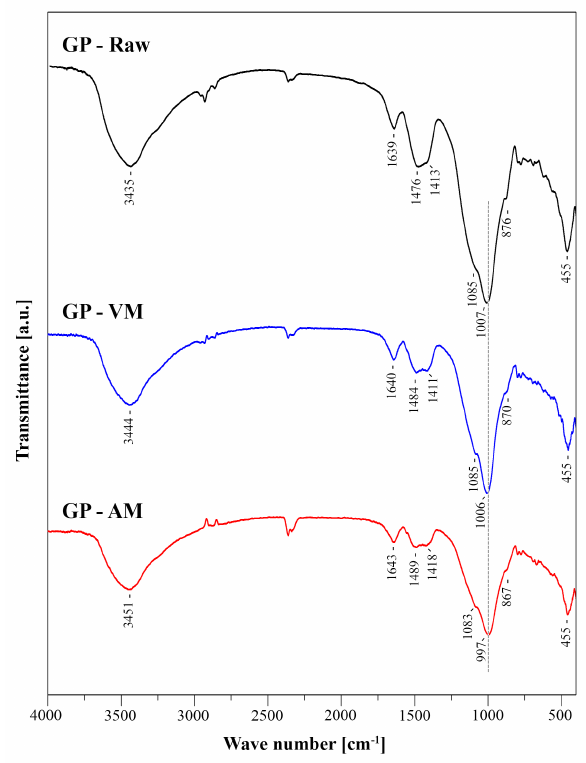
Figure 6: FTIR spectra of geopolymers prepared from raw and milled fly